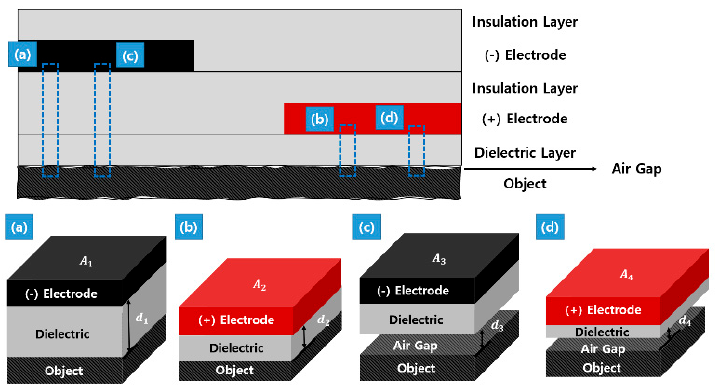
Figure 5. Structure approximation of the dual-insulation pad for modeling: ( a ) without gap at ( − ) electrode; ( b ) without gap at (+) electrode; ( c ) with gap at ( − ) electrode; ( d ) with gap at (+) electrode.